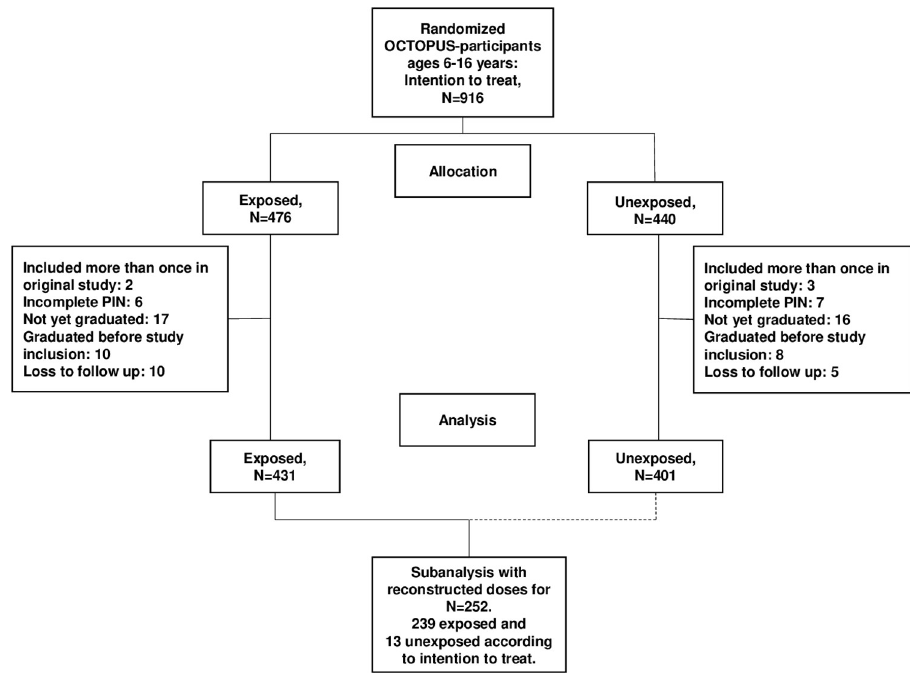
Fig 1. Flow chart of